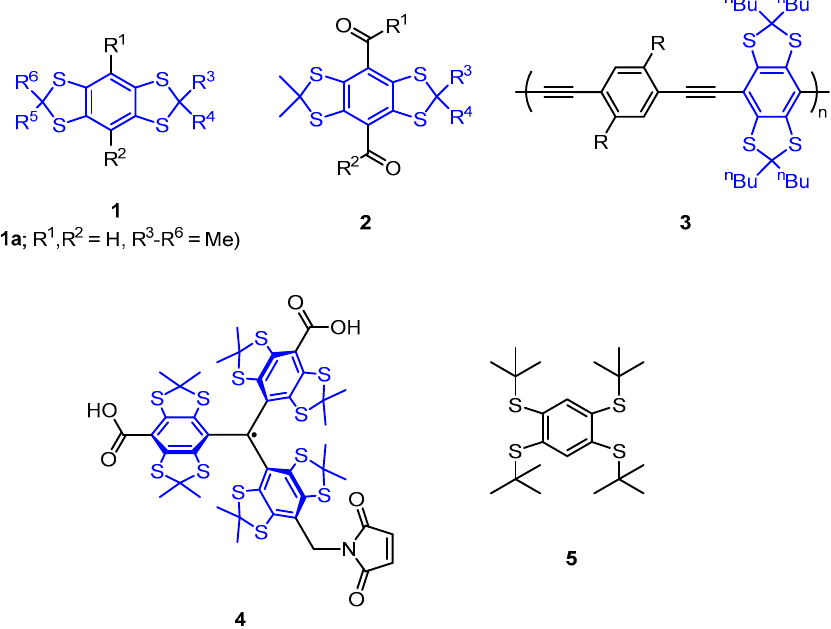
Figure 1. Lewis structures of benzo[1,2 d;4,5 d’]bis[1,3]dithioles 1 , “S4-DBD” dyes 2 , thioketal containing conjugated polymers 3 , spin label 4 ● and 1,2,4,5-tetrakis(tert-butylthio)benzene 5 . For the sake of clarity, the benzo[1,2-d;4,5-d’]bis[1,3]dithiole motif is highlighted in blue.